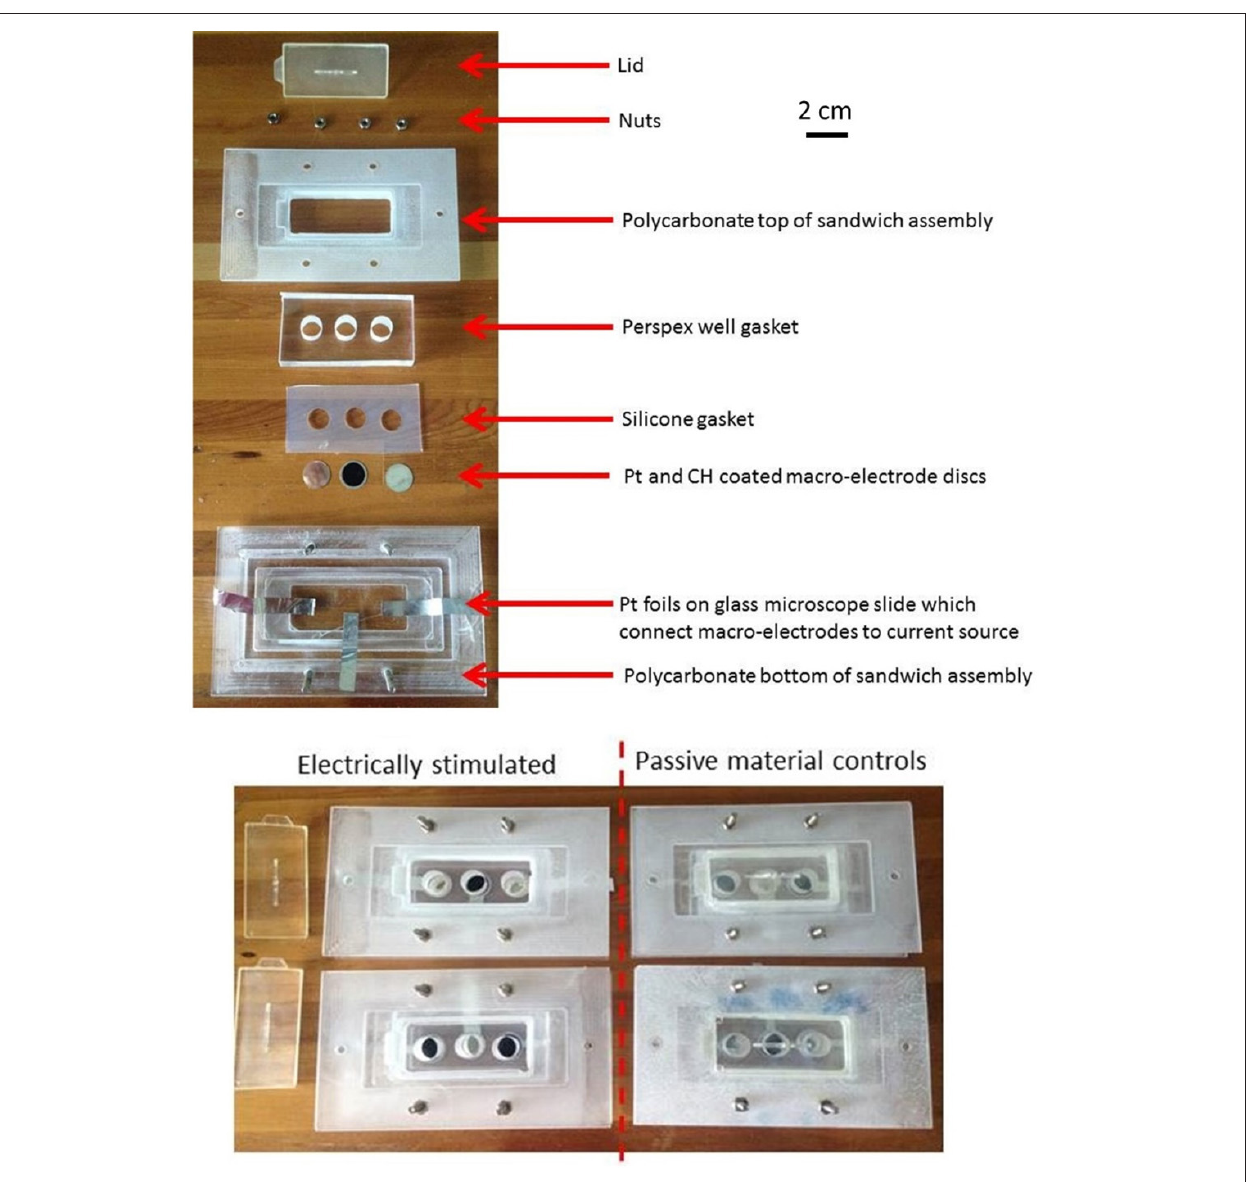
FIGURE 1 | The individual and assembled components of the electrical stimulation rigs with Pt and CH coated electrode substrates.